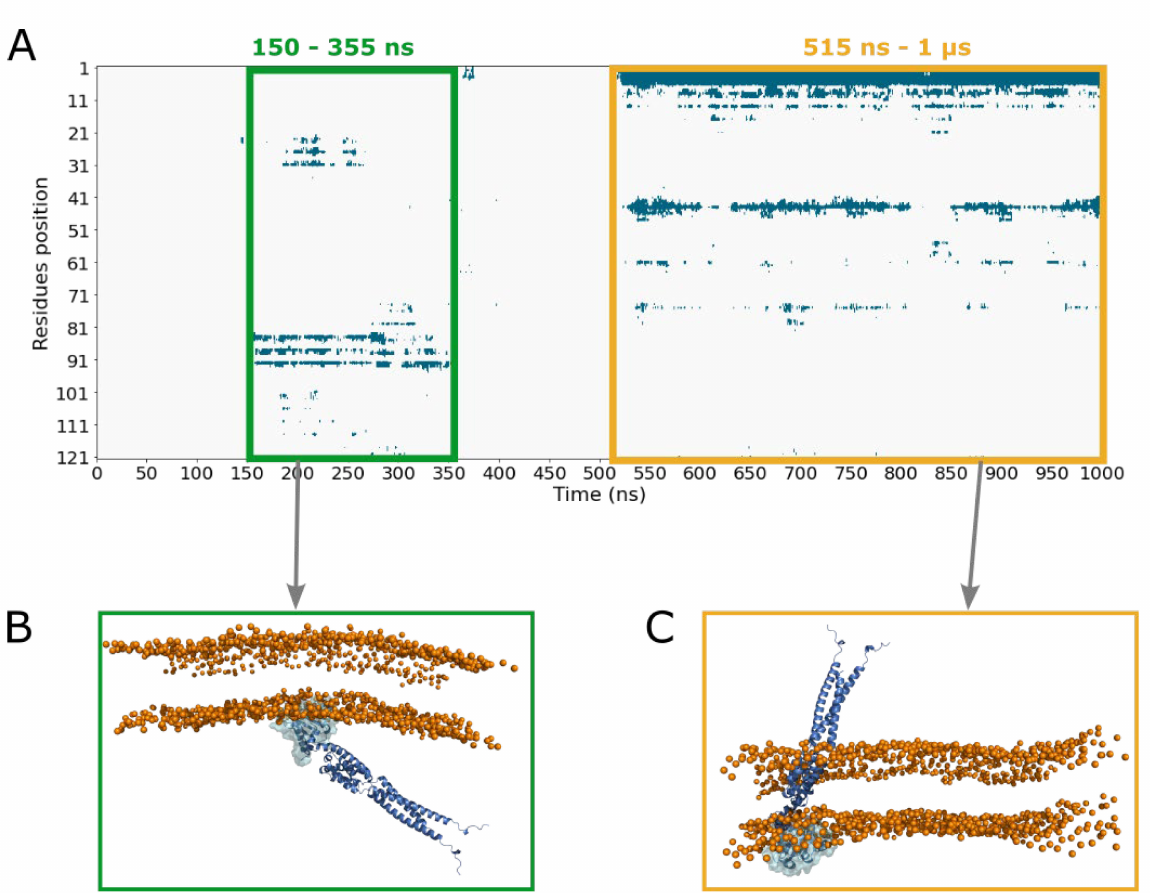
Figure 8. Adsorption of the single SCP2 domain onto the membrane from CG simulation. ( A ) Contact map of the SCP2 domain with the membrane in CG simulations, ( B ) representative snapshot of the first identified binding mode according to contact map (around 200 ns), ( C ) representative snapshot of the second identified binding mode according to contact map (around 880 ns). For both snapshots, single SCP2 domain adsorbed on the membrane is shown in transparent surface. The full heterotrimer is displayed in cartoon representation and was superimposed onto the SCP2 domain. For clarity, orange spheres represent the polar head groups of the